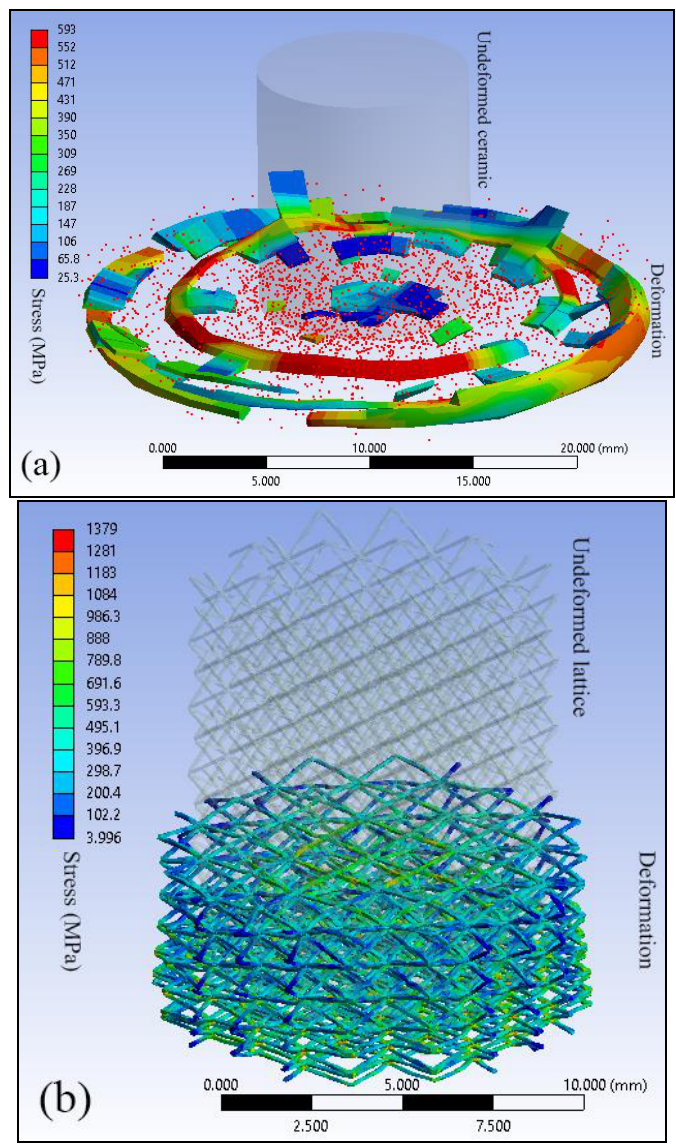
Figure 11. Compressive strength modelling of ( a ) TiO 2 ceramic, ( b ) Ti6Al4V lattice structure. Simulation conditions and dimensions are identical for the ceramic and lattice structures.